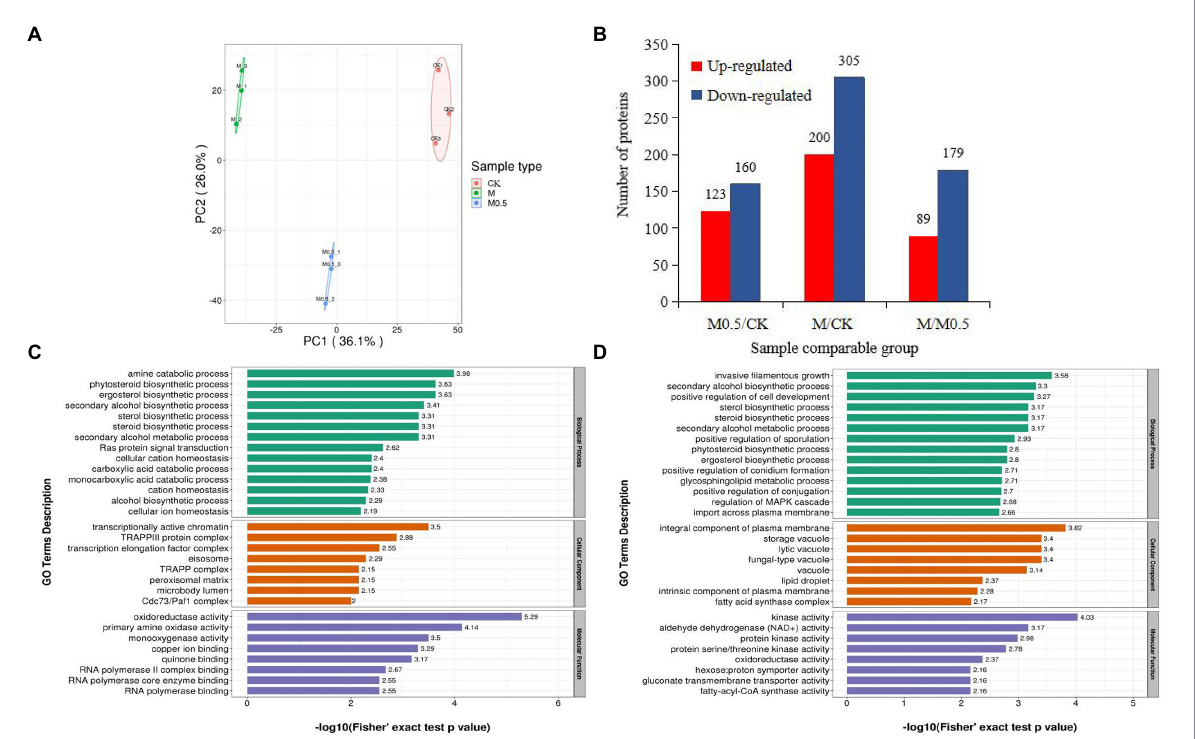
FIGURE 6 Number of enriched proteins and GO classification involved in specific biological processes in different comparisons. (A) Principal component analysis of protein quantification among 3 replicate samples. (B) Number of differentially expressed proteins (DEPs) identified in three comparision groups. (C) GO enrichment analysis of DEPs in M0.5 vs. CK (C) and in M vs. CK (D) including biological process, cellular component and molecular function. Green columns represented the categorization of biological process, orange columns represented the categorization of cellular component, and blue columns represented the categorization of molecular